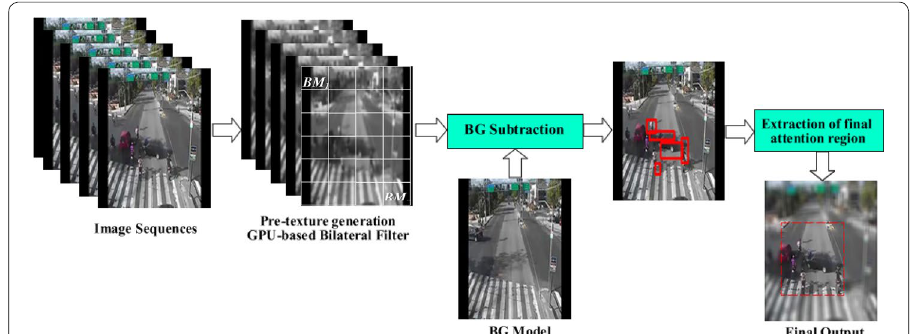
Fig. 3 Step-by-step of finding visual attention region